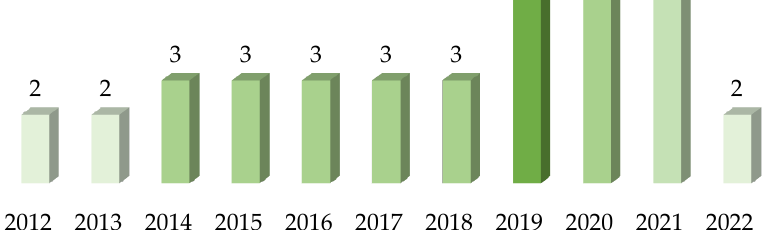
Figure 4. Number of publications per journal.